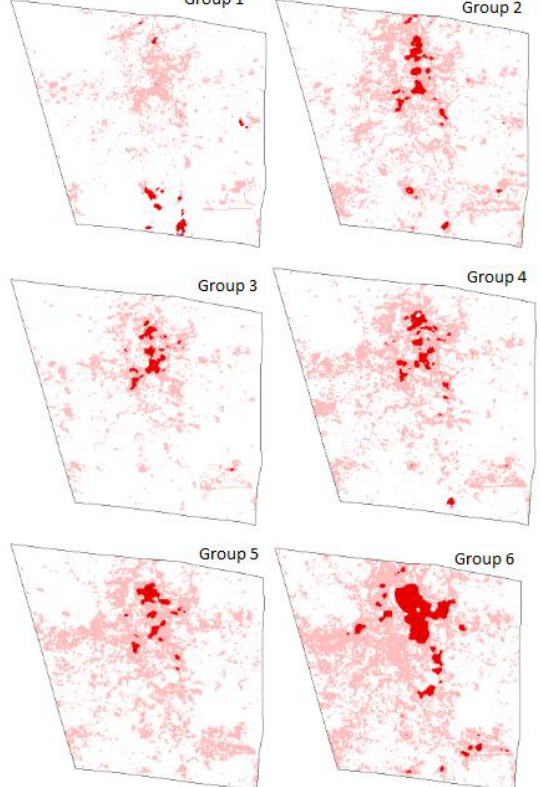
Figure 9. Hotspots per input group (highlighted in red) overlaid to the equivalent Landsat-derived built-up maps (in light red)